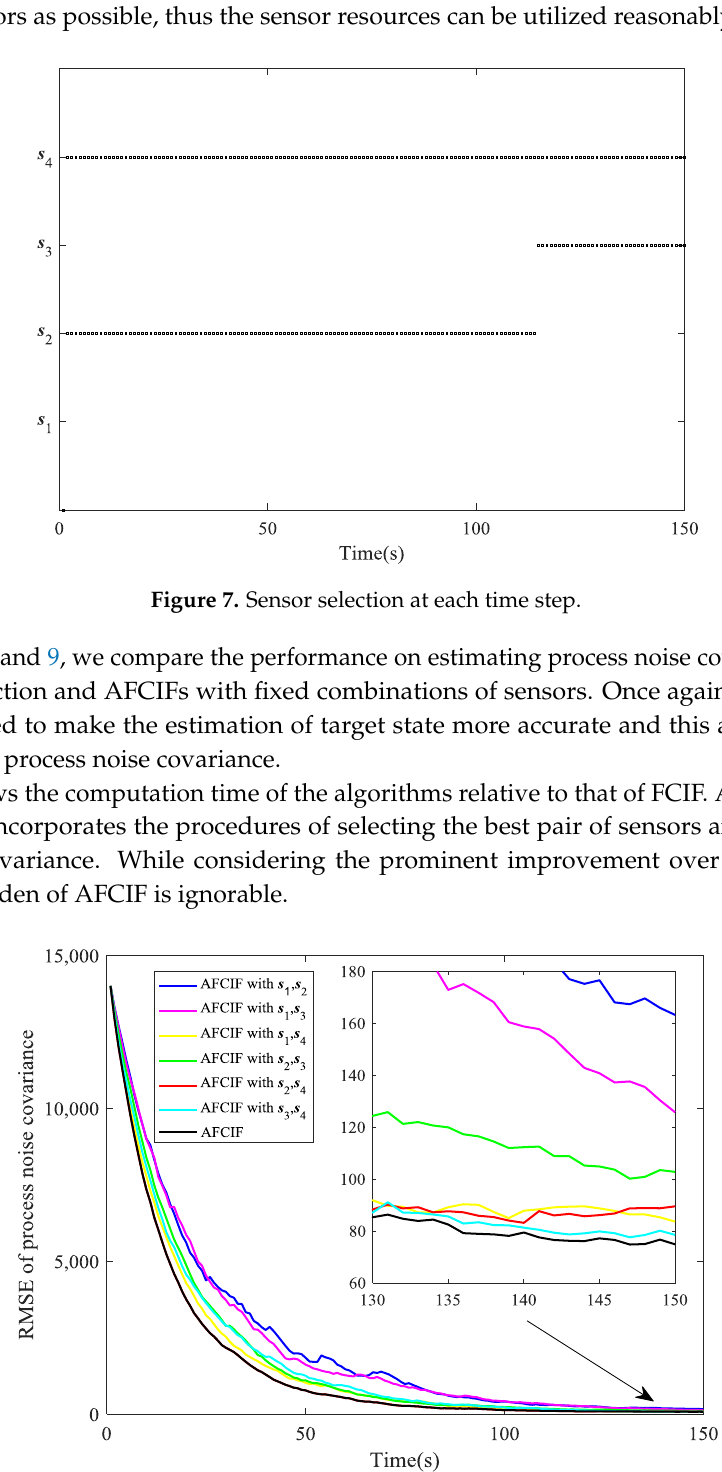
Figure 6. Comparison of posterior Cramér-Rao lower bound (PCRLB).